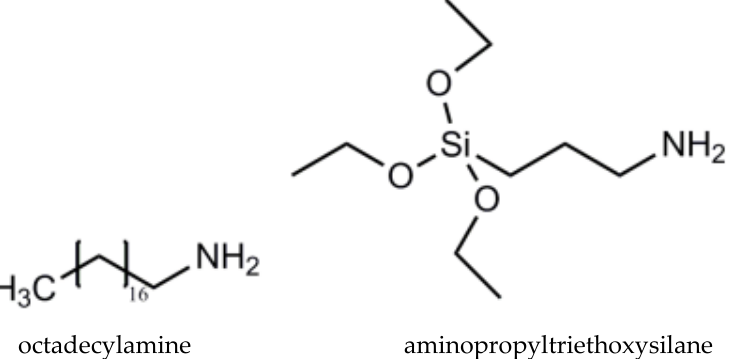
Figure 11. Chemical structure of Nanomer ® I.31PS (Adapted with permission from Ref. [31]. Cop- yright 2023 John Wiley and Sons). right 2023 John Wiley and